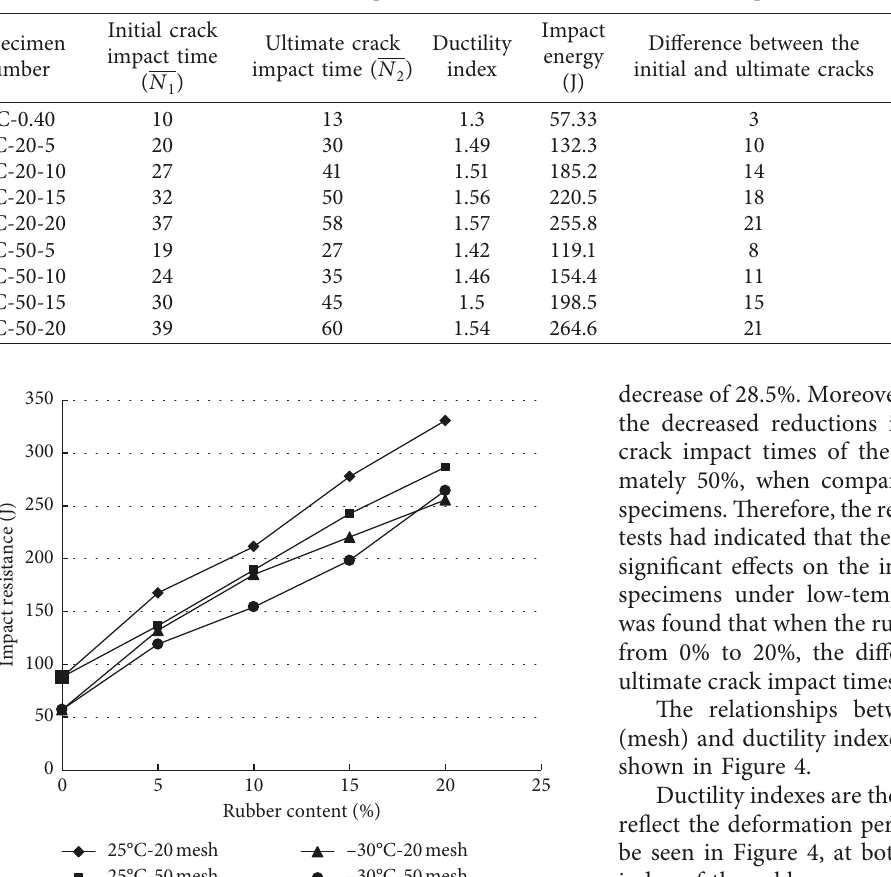
Table 9: Impact test results for the rubber concrete specimens at − 30 ° C.